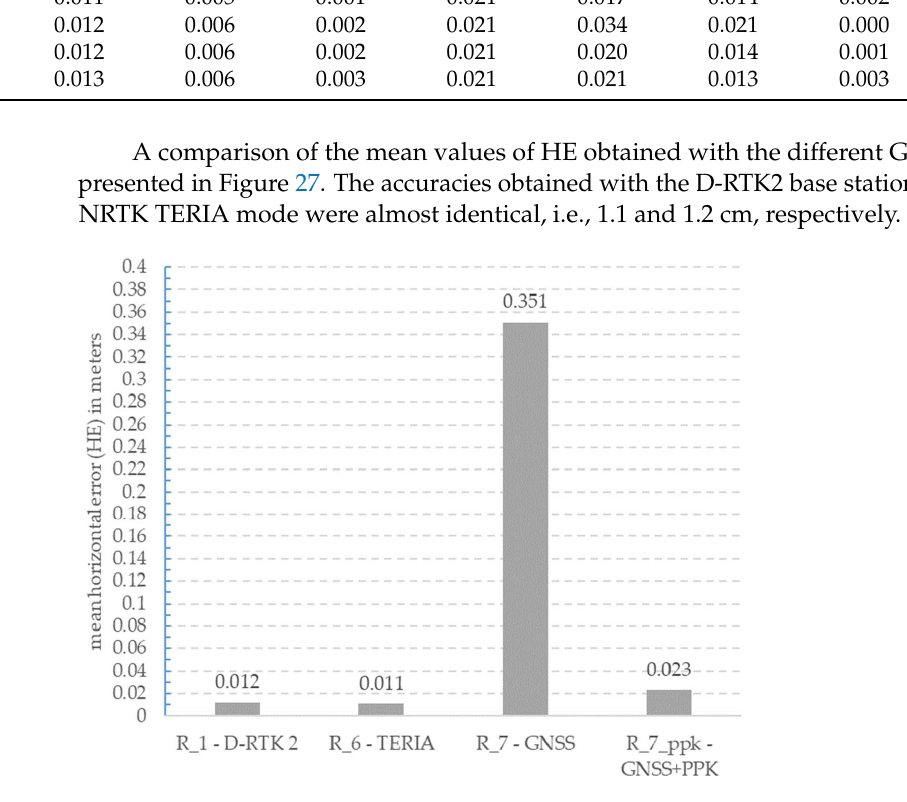
Figure 27. Mean horizontal error (HE) calculated on the 17 GCPs for four GNSS modes.